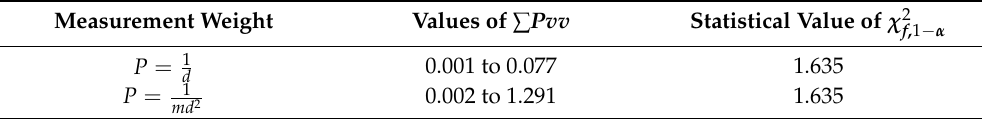
Table 2. The results of Chi-square test. Measurement